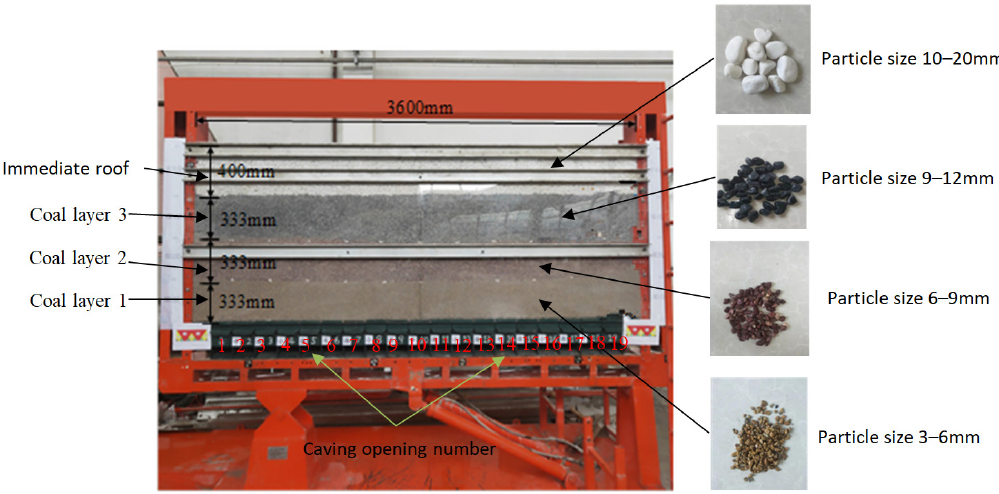
Figure 10. Physical picture of laying scheme.